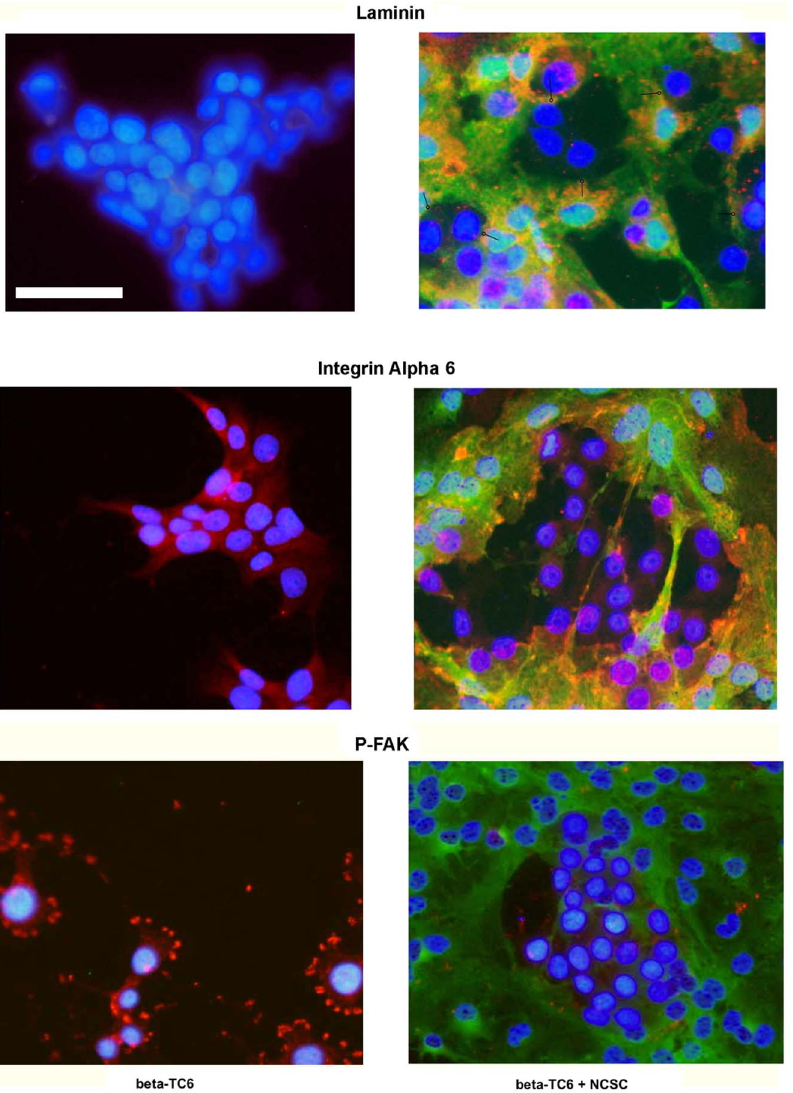
Figure 4. Co-culture of beta-TC6 cells with NCSCs affects beta-TC6 cell focal adhesions. Non-GFP positive beta-TC6 cells were either cultured alone (left panels) or together with GFP-positive NCSC cells (right panels, green cells) on laminin-coated cover slips. Cells were treated with 20 ng/mL of IL-1 b and 20 ng/mL of IFN- c for 48 hours and were then fixated, permeabilized and stained for laminin (orange), integrin alpha VI (orange) or phospho-FAK(Y397) (red). Nuclei were visualized by Hoechst. Fluorescence was photographed in a fluorescence microscope using a 20 6 lens. Circleheads indicate positions of NCSC laminin accumulations close to beta-TC6 cells. The scale bar depicts a distance of 50 m m. Results are representative for three independent